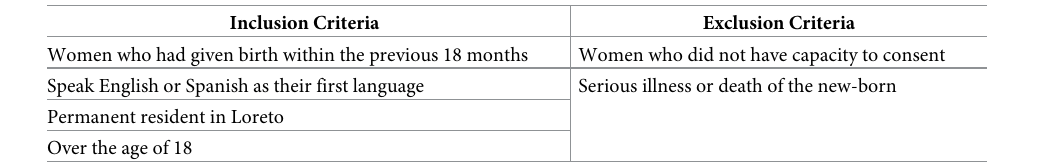
Table 1. Eligibility